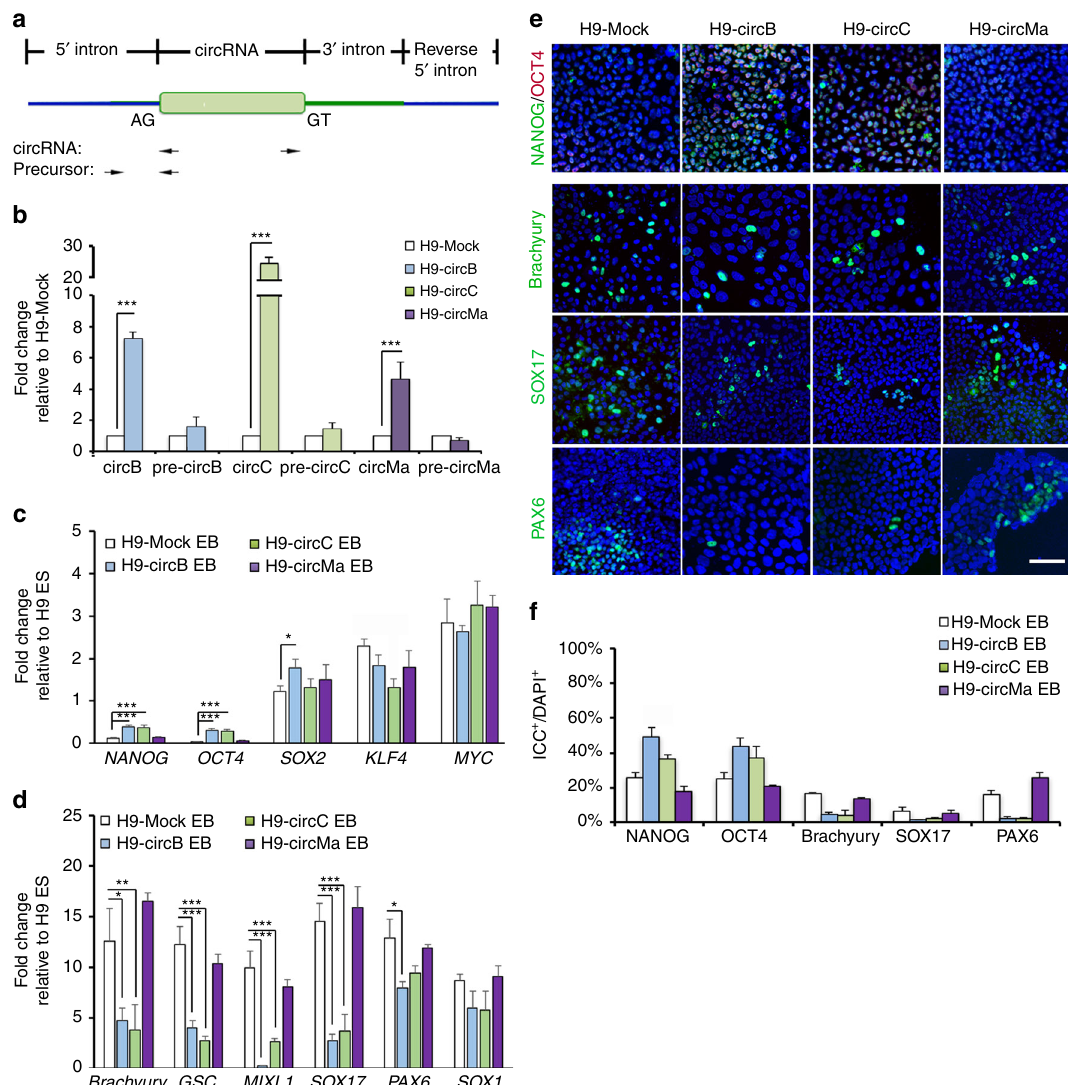
Fig. 3 CircBIRC6 or circCORO1C promote hESC pluripotency . a Schematic illustrating the major components of circRNA minigene constructs. Arrows indicate the placement and direction of RT-qPCR primers used to amplify circRNA or precursor transcripts. b – d RT-qPCR analysis of the expression of b circRNAs and their precursor transcripts, and the indicated c pluripotency-associated genes and d lineage-associated genes in hESCs transfected with a circRNA minigene (H9-circB, H9-circC, and H9-circMa) cultured under differentiation conditions. e ICC analysis and f quantitative analysis of the expression of the pluripotency and lineage markers as indicated in hESCs transfected with a circRNA minigene (H9-circB, H9-circC, and H9-circMa) and cultured under differentiation conditions. Nuclei were stained with DAPI (blue). Scale bar: 20 μ m. Quantitative data from three independent experiments is presented as mean ± SD (error bars). P -values were determined by two-tailed two-sample t -tests (* P < 0.05; ** P < 0.01; *** P <